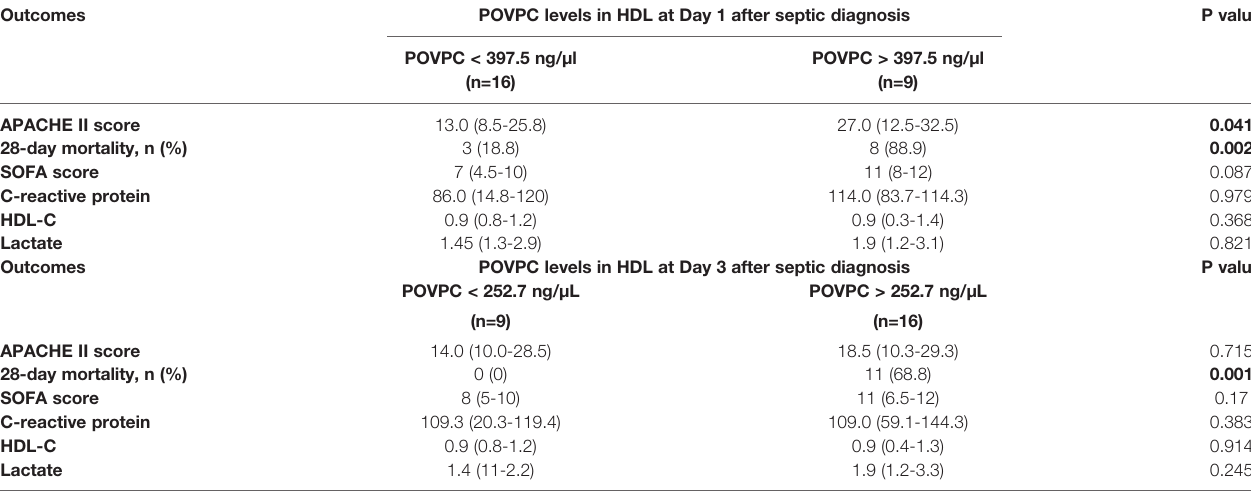
TABLE 5 | Hospital outcomes by HDL POVPC-D1 and HDL POVPC-D3 cutoff values in septic patients.